Question: Author a descriptive caption for the visualization shown.
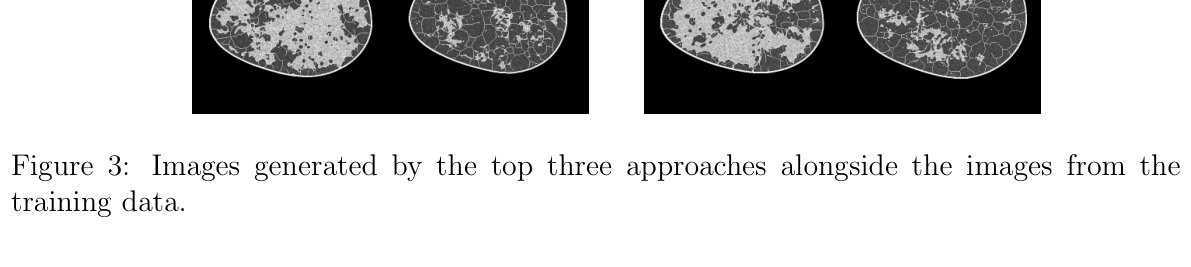
Answer: shows the images generated by the top three approaches. It can be seen that they display a high degree of perceptual similarity to the provided training images. However, they still retain imperfections, as identified and discussed further in Section IV.E. The FID scores for the 12 unique submissions are reported in Figure 4a. Boxplots of memorization measure values computed for 3,000 synthetic images with respect to the training data are shown in Figure 4b. The submissions that produced images with memorization measure